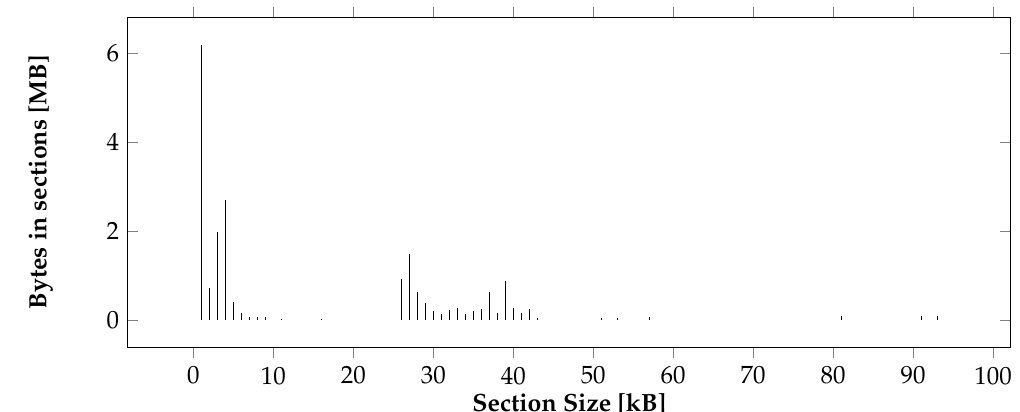
Figure 2. A histogram of the distribution of bytes in differently sized PROGBITS sections in the source object files of Thingsee